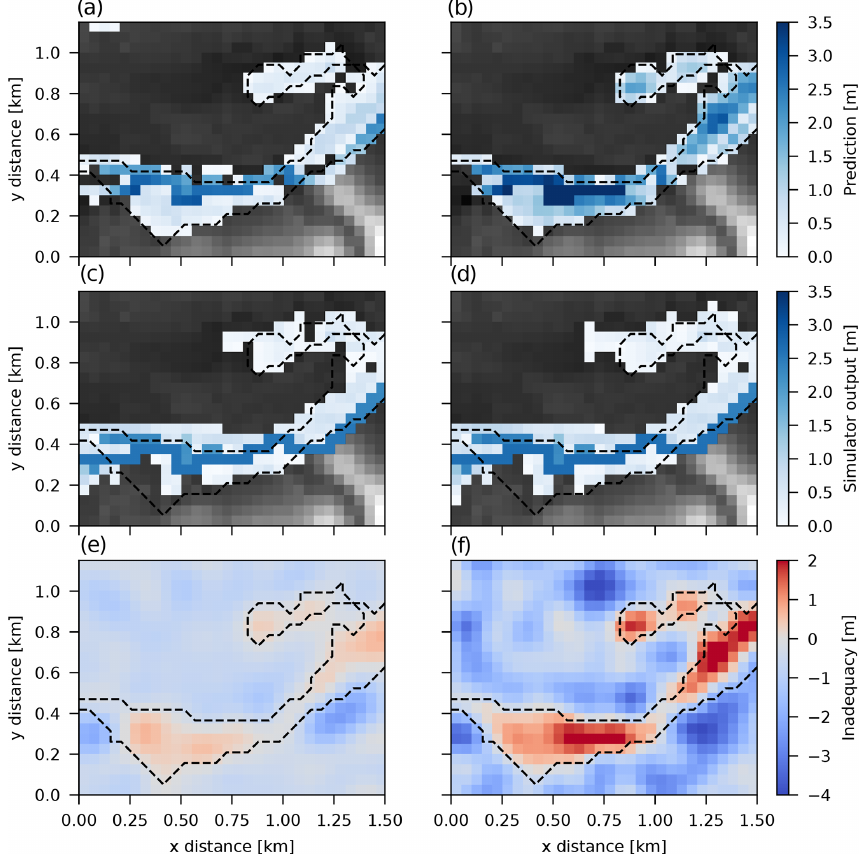
Figure 14. Flood-depth maps from Model 3 predictions of the simulator and inadequacy (a, b) , the simulator alone (c, d) , and inade- quacy (e, f) for a marginal prior mode of θ 1 = 0 . 05 (a, c, e) and θ 1 = 1 (b, d, f) . The dashed black line is the observed flooded extent.